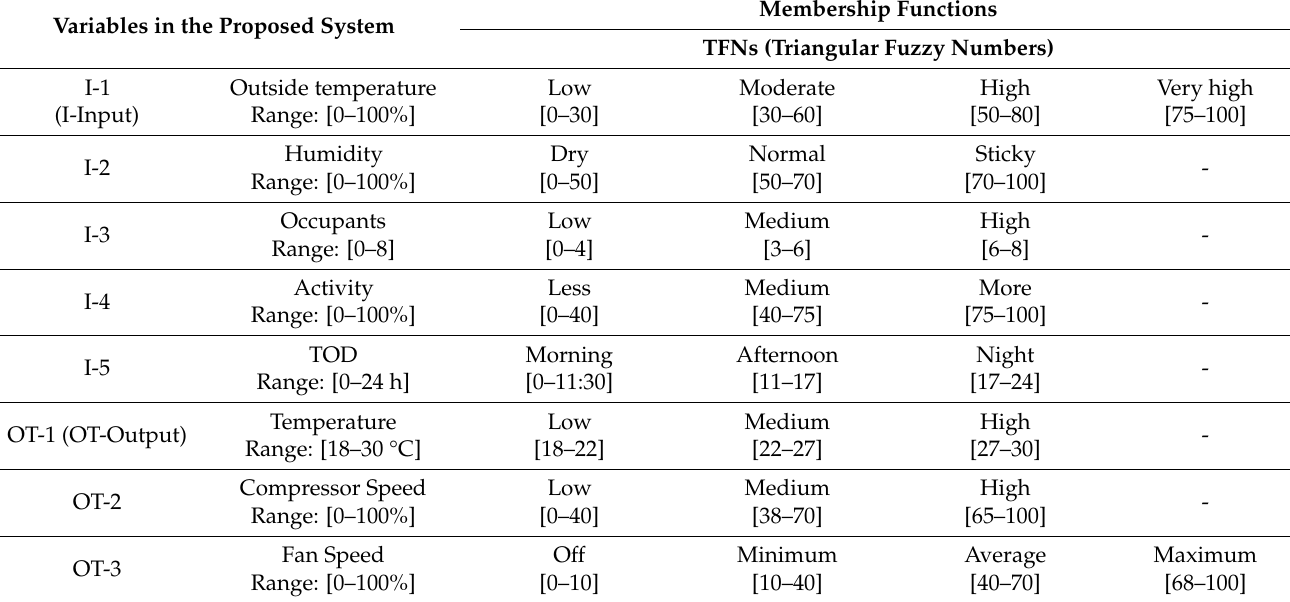
Table 1. Variable classifications and their membership functions.